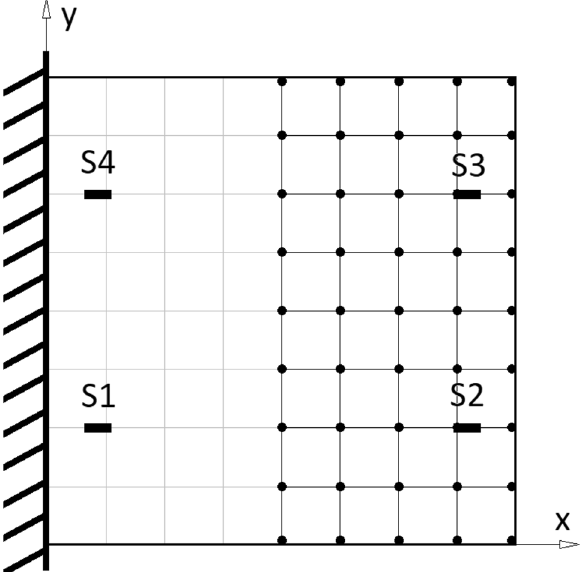
Fig. 10 Location of arbitrary test points A to D measured at (812,995), (562,620), (687,255) and (937,5) ± 2 mm,